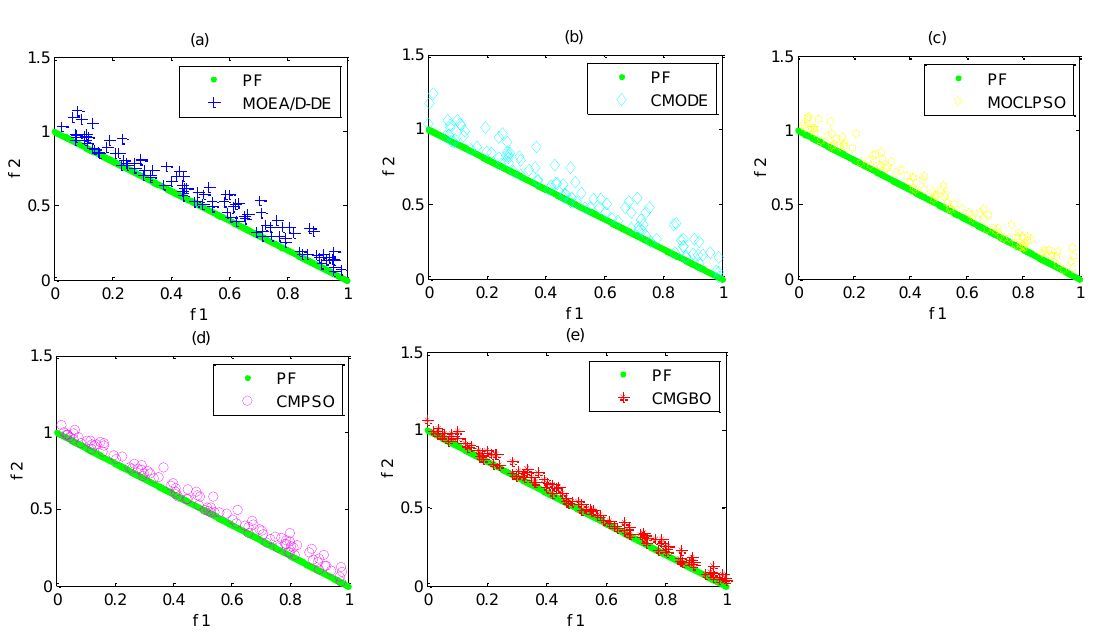
Figure 4. Non − dominated solutions of UF1: ( a ) MOEA/D-DE; ( b ) CMODE; ( c ) MOCLPSO; ( d ) CMPSO; ( e ) CMGBO.